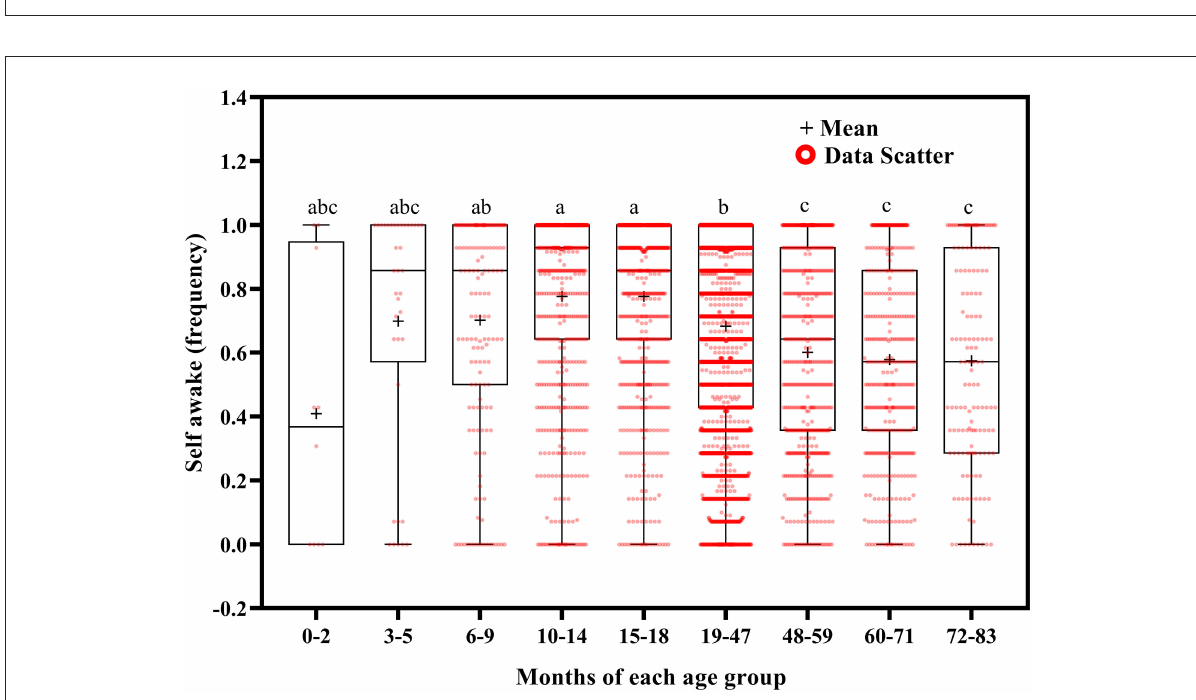
FIGURE11 Results of the one-way ANOVA for self-awake stratified by age.